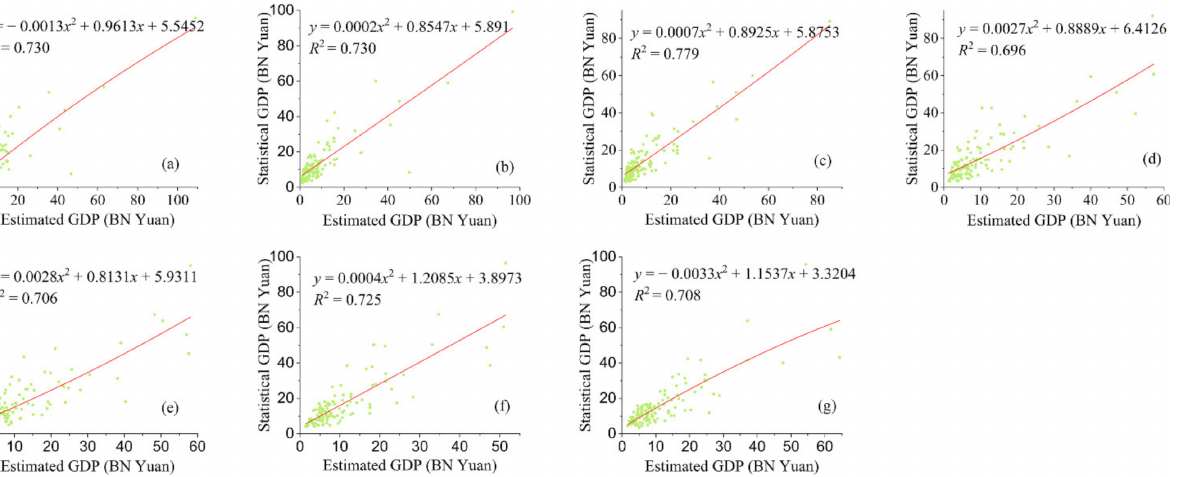
Figure 11. Correlations between annual statistical GDP and estimated GDP at the county scale for